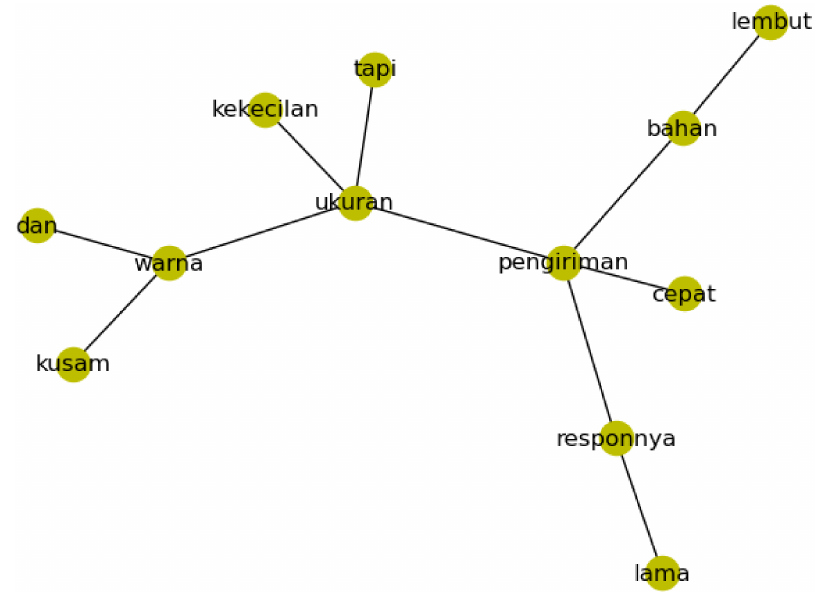
Figure 4. An example of graph